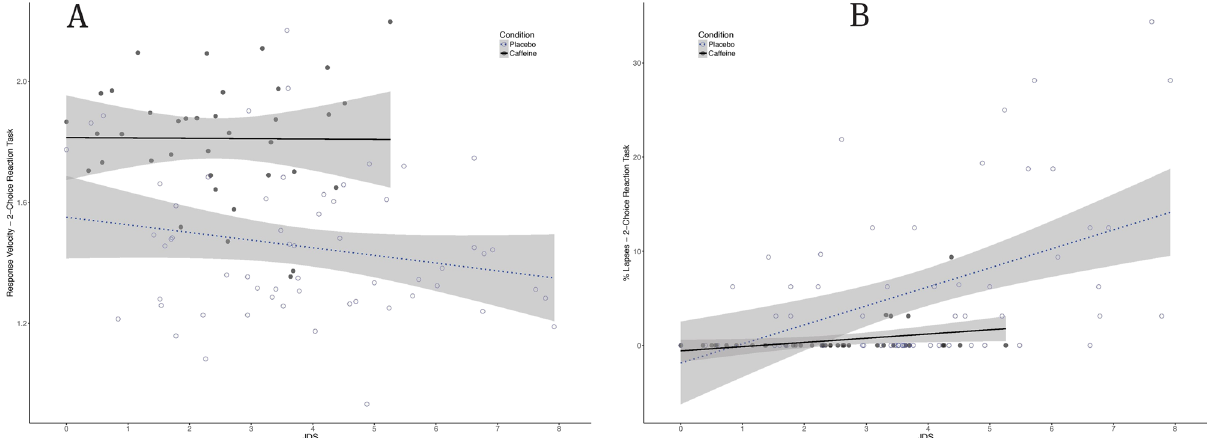
Figure 3. Performance on the 2-Choice Reaction task (PRT) as a function of drowsiness (JDS scores averaged over 5 min prior to the task) for the caffeine (black filled circle, n = 4) and placebo (black open circle, n = 6) groups across our 50-h TSD protocol. ( A ) Response velocities (s -1 ). ( B ) Percentage of Response Lapses. Shaded areas represent 95% CIs over regression lines.